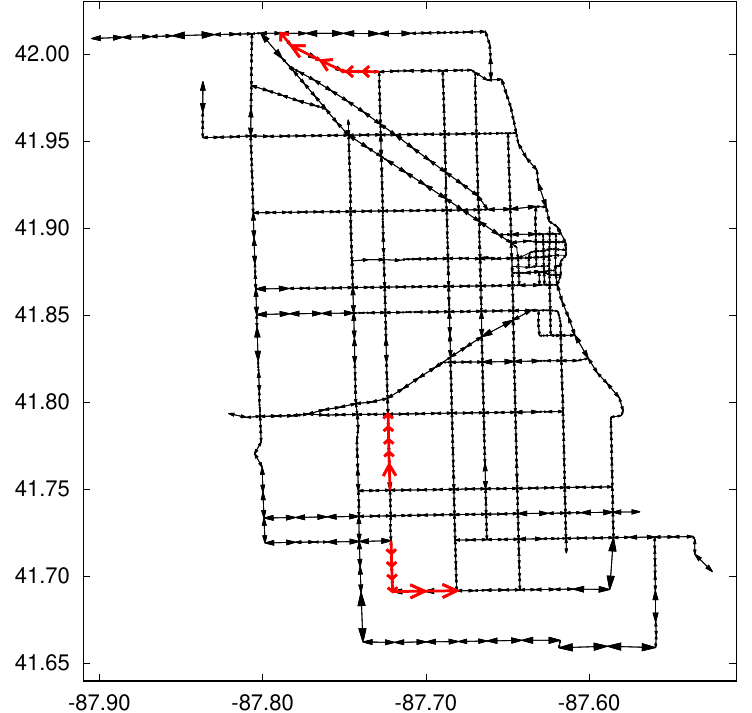
Figure 5 Experiment 4: Chicago graph with three regions highlighted.